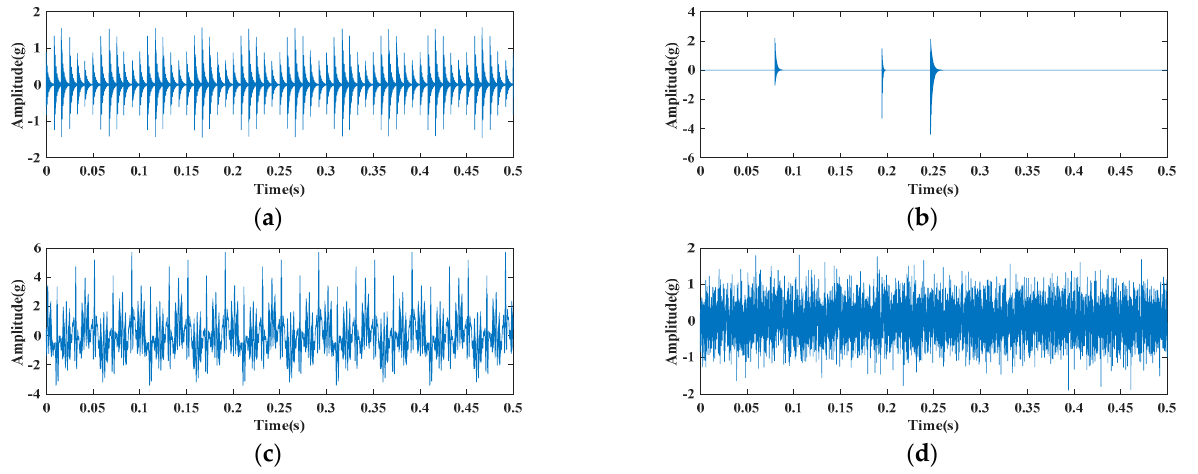
Figure 1. Components of the simulated signal: ( a ) fault feature signal; ( b ) random impulses; ( c ) harmonic components; ( d ) white noise.